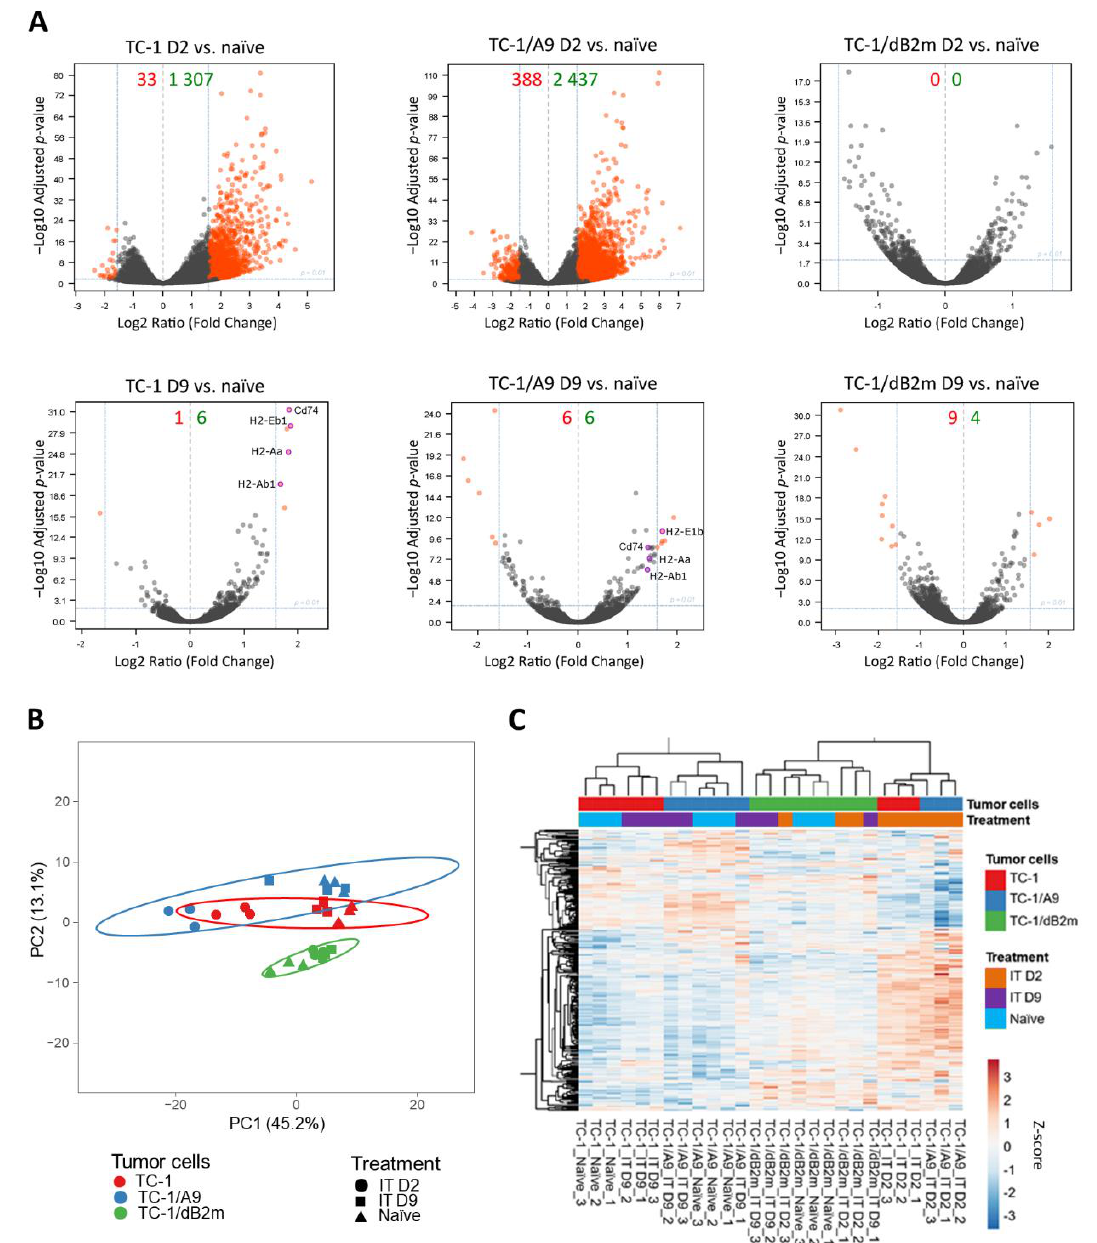
Figure 1. RNA-seq analysis of the TME. RNA was isolated from naïve tumors and tumors 2 (D2) or 9 days (D9) after IT termination. ( A ) Differential expression of all detected genes. Orange dots indicate genes with at least 3-fold increased or decreased expression and padj ≤0.01. Numbers of these genes are indicated in green and red colors, respectively. ( B ) PCA of the expression of immune-related genes. ( C ) Cluster analysis of gene sets associated with macrophages.